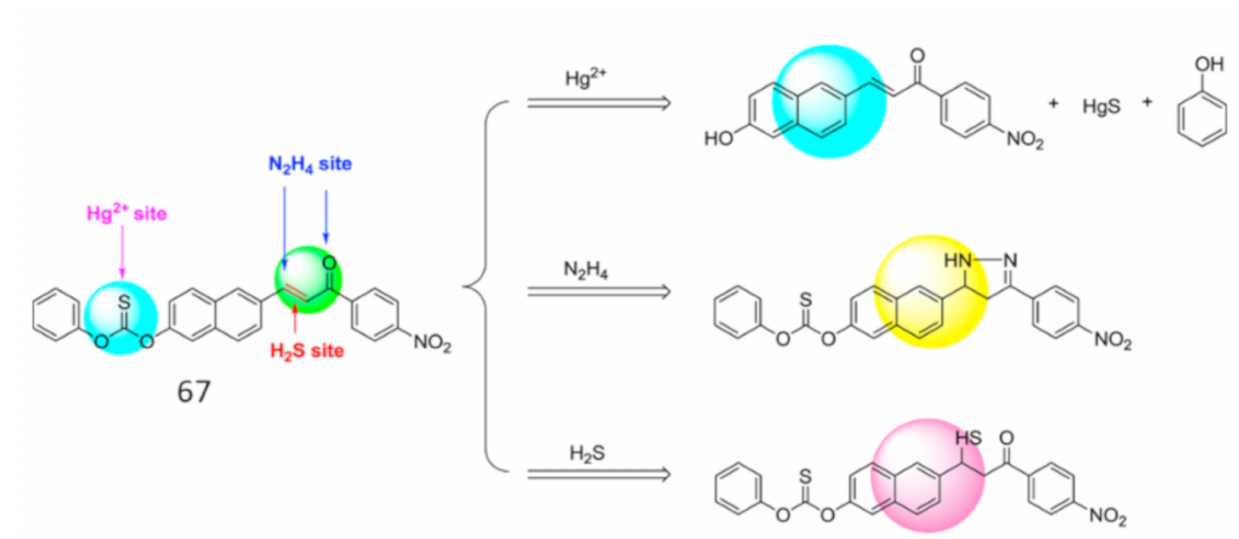
Figure 24. Reaction-based sensing mechanism of 67 with Hg 2+ , N 2 H 4 and H 2 S. Reproduced with permission from [95]. Copyright 2020